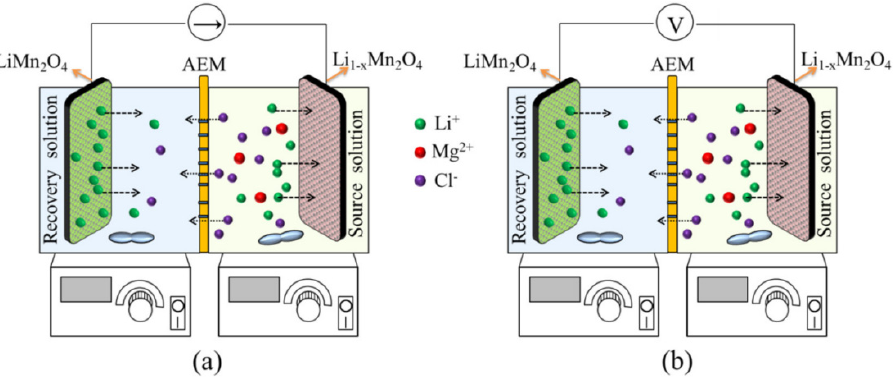
Figure 2. Schematic of lithium extraction with the driving mode of ( a ) CC and ( b ) CV [22]. 3. Research Progress of Working Electrode Materials in Electrochemical Extraction of Li from Brine